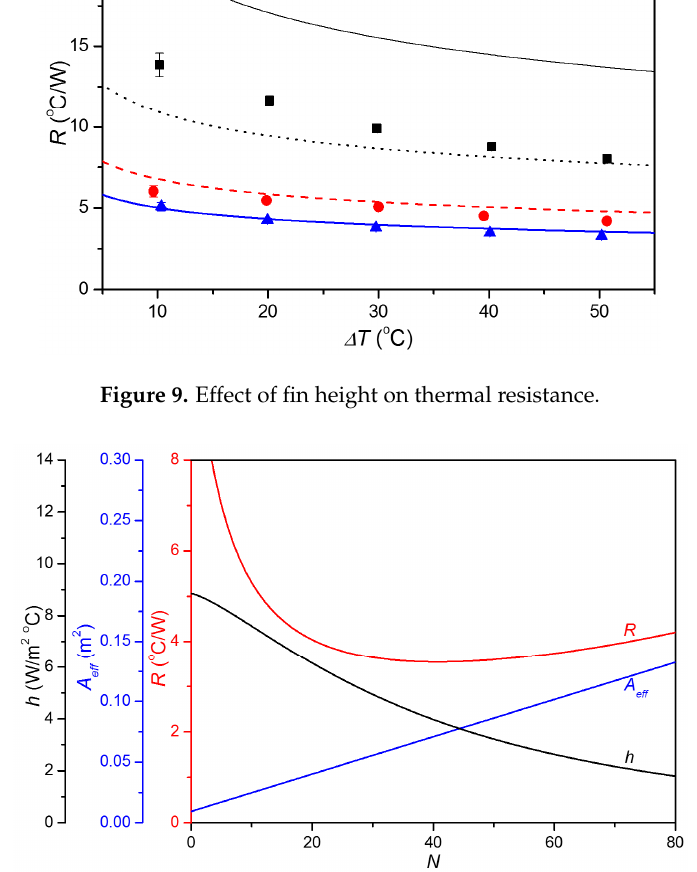
Figure 10. Effects of fin number on effective surface area, heat transfer coefficient, and thermal